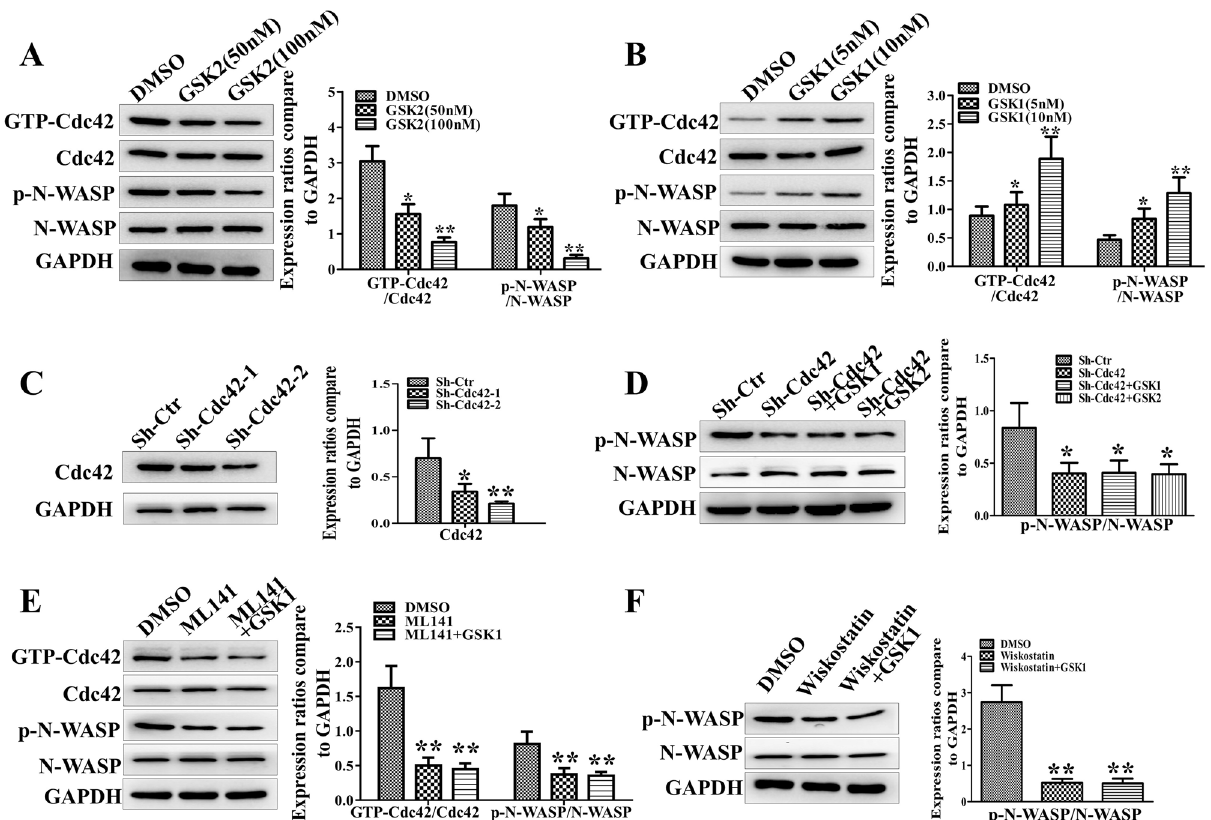
Figure 5. TRPV4 regulates Cdc42/N-wasp axis in glioblastoma cells. ( A – B ) Pull-down and western blot assays showing Cdc42/N-wasp axis activation in U87 cells treated with antagonist (50 nM or 100 nM) or agonist (5 nM or 10 nM). ( C ) Western blot assays show the knockdown effect of two sequences of sh-Cdc42 in U87 cells. ( D ) The activation of N-wasp was detected by western blot after knockdown Cdc42 or combined with GSK2 and GSK1. ( E ) Western blot analysis of the activation of the Cdc42/N-wasp axis after ML141 (Cdc42 inhibitor, 500 nM) treatment or combined with TRPV4 agonist. ( F ) The activation of N-wasp was detected by western blot assay after treatment with wiskostatin (N-wasp inhibitor, 5 µM) without or with TRPV4 agonist. * p < 0.05, ** p <